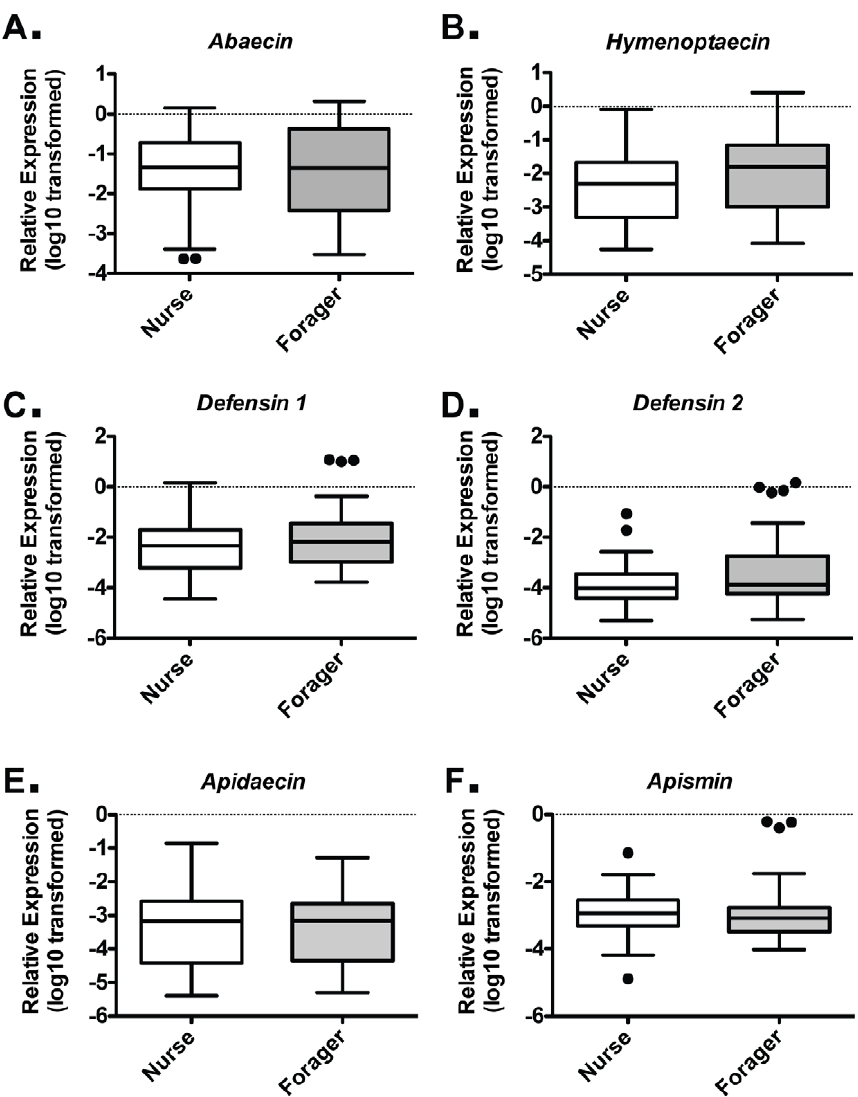
Figure 2. Similar midgut barrier AMP expression in nurse and forager stages. Individual levels of the six honey bee AMPs relative to b -actin in midgut tissue for Nurses (n=46) and Foragers (n=45), as assessed by behavior and location cues, for Abaecin (A), Hymenoptaecin (B), Defensin 1 (C), Defensin 2 (D), Apidaecin (E), and Apisimin (F) from the six trials. Boxes show 1st and 3rd interquartile range with line denoting medians. Whiskers encompass 95% of the individuals. Outliers are denoted with filled